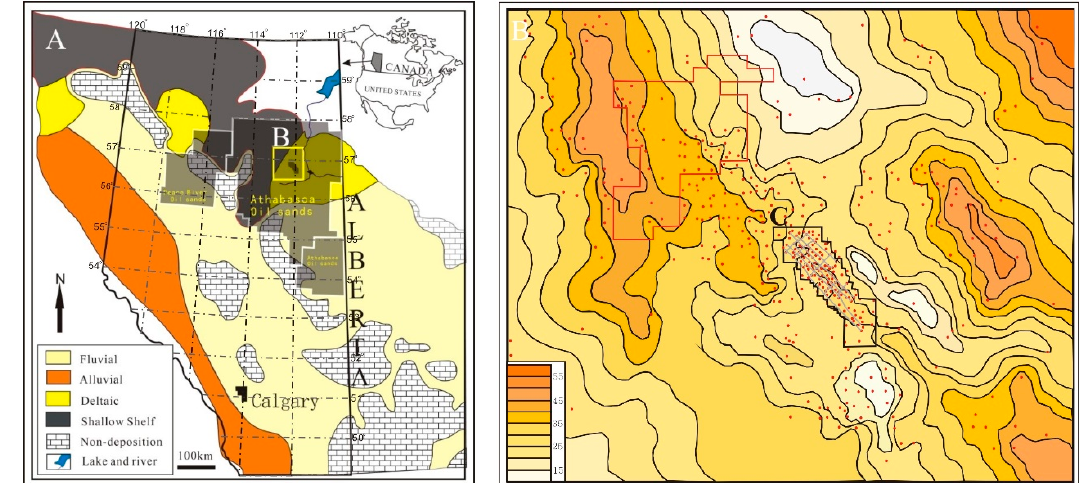
Figure 1. Generalized paleographic map (modified from Labrecque et al., 2011 [10]; Musial et al., 2012 [11]) and isopatch map of sand body thickness of the McMurray formation. ( A ) shows the Athabasca Oil field area; ( B ) represents sand body thicknesses.